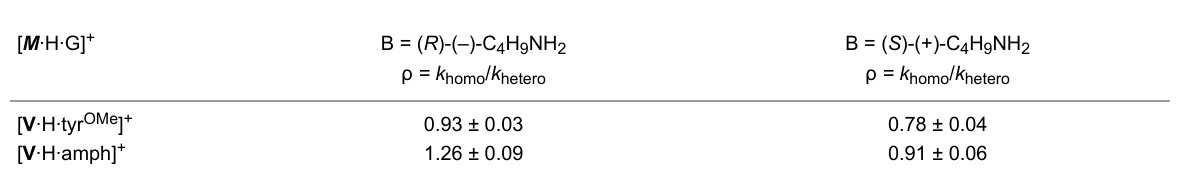
Table 2: Exchange rate constants ( k × 10 − 10 cm 3 molecule − 1 s − 1 ).